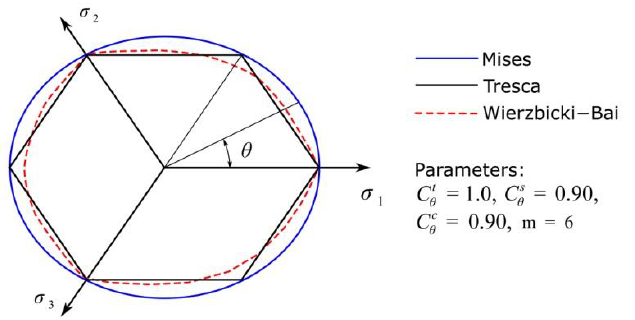
Figure 2. Yield surfaces for various yield criteria.